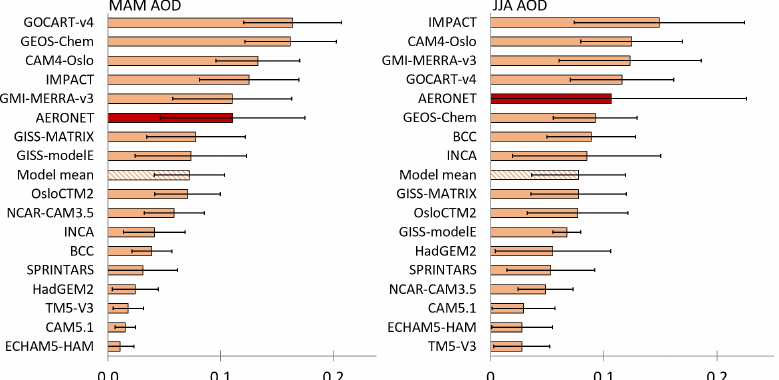
Figure 4. Multi-model AOD averaged for the spring (MAM) and summer (JJA) for the nine Arctic AERONET stations in Fig. 2 (details Table 2). The red bar is the average observation over the nine stations and the striped bar is the multi-model average. The error bars represent 1